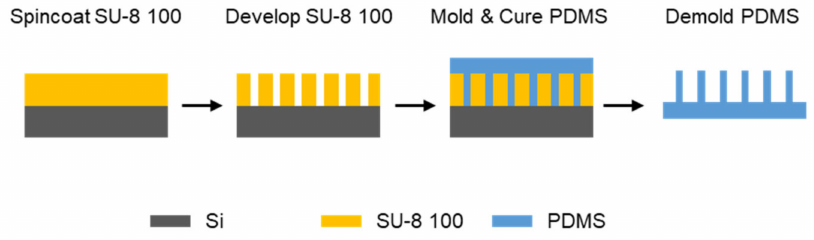
Figure 2. Fabrication of an SU-8 mold and an elastomer ridge